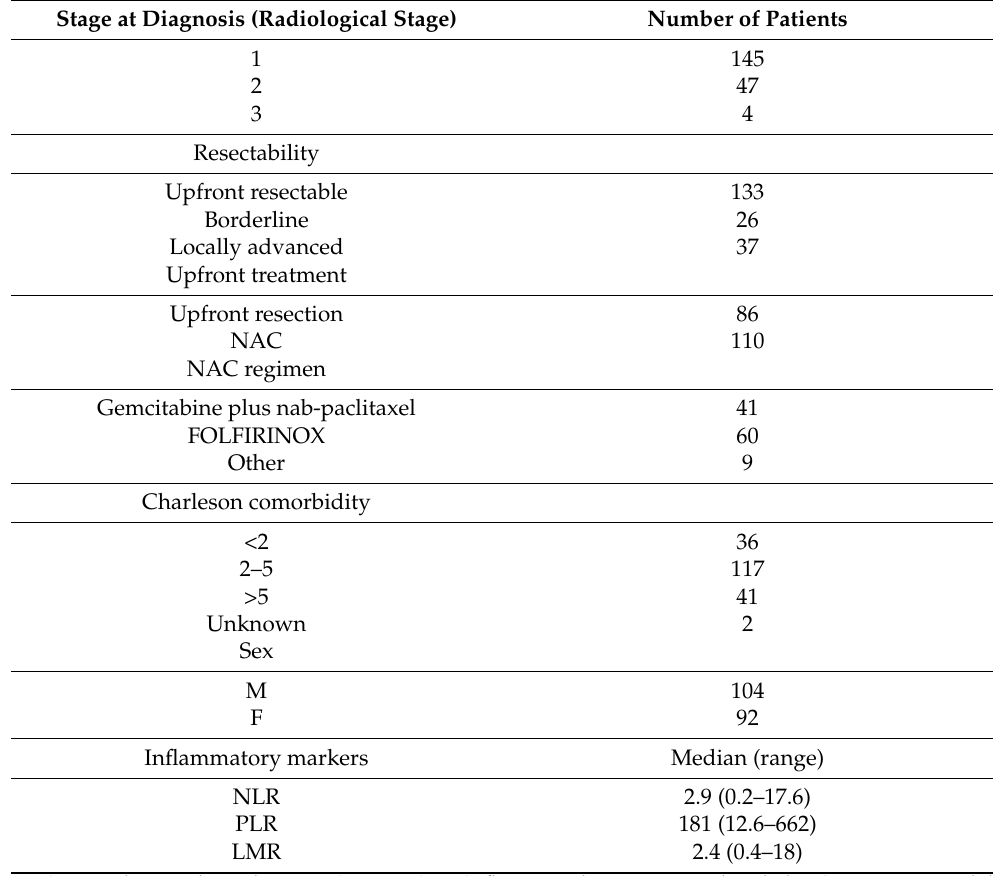
Table 1. Baseline characteristics. Stage at Diagnosis (Radiological